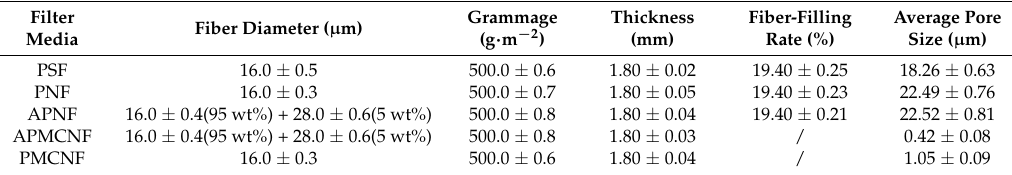
Table 1. The performance parameters of the five tested filter media.